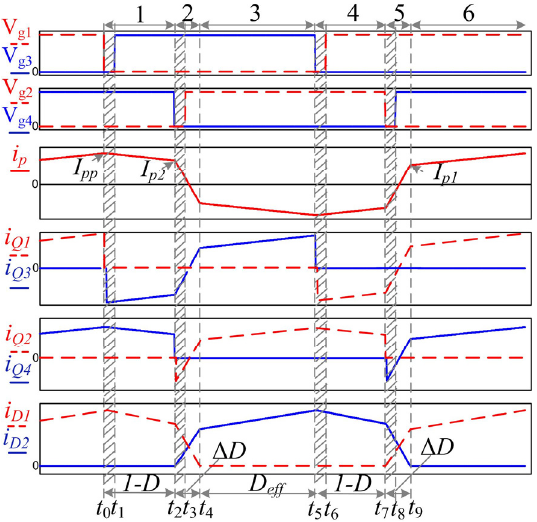
Figure 2. Key waveforms of the PSFB converter in CCM